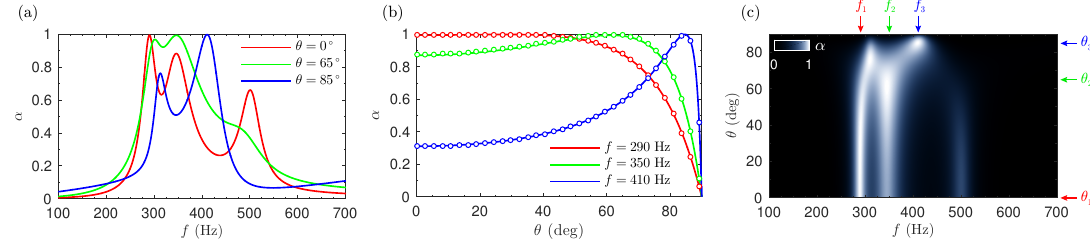
Figure 4. ( a ) Absorption of the metamaterial using N = 3 HRs as a function of the frequency, for incidence angles θ = 20 ◦ ,65 ◦ ,85 ◦ ; ( b ) Angle-dependent absorption obtained using TMM (continuous lines) and Equation (10) (circles) at frequencies f = 290,350,410 Hz; ( c ) Map of the absorption as a function as the frequency and incidence